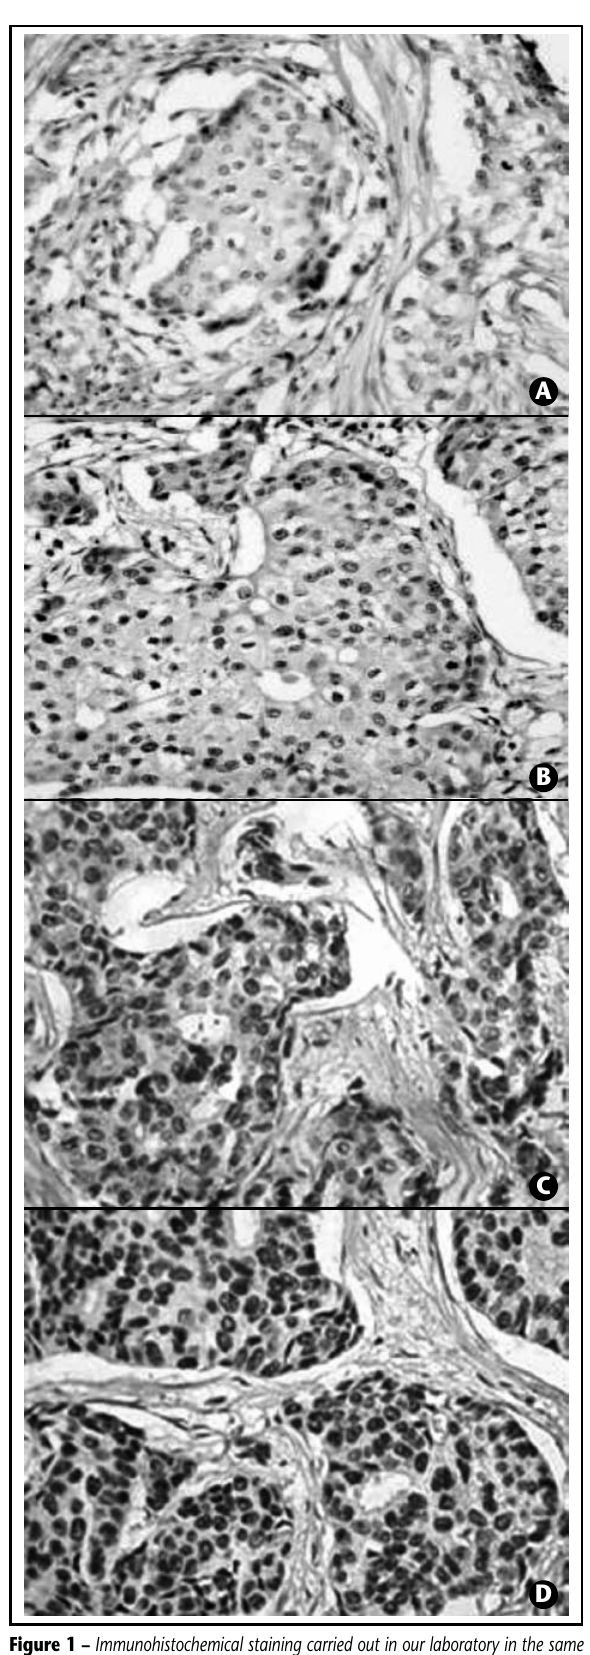
Figure 1 – Immunohistochemical staining carried out in our laboratory in the same tumor: ER and PR staining using mouse monoclonal antibodies anti-ER, clone 1D5 (A); and anti-PR, clone PgR 636 (C); and rabbit monoclonals anti-ER, clone SP1 (B); and anti-PR, clone SP2